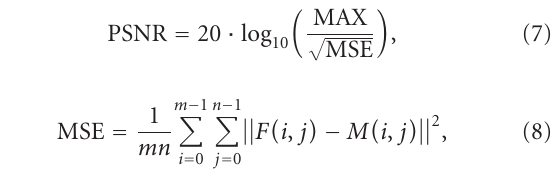
Figure 8: 3D surfaces shaped by corresponding fuzzy rules. approach and mathematical approach the Peak Signal-to- Noise Ratio (PSNR) parameter is used for comparison (7).